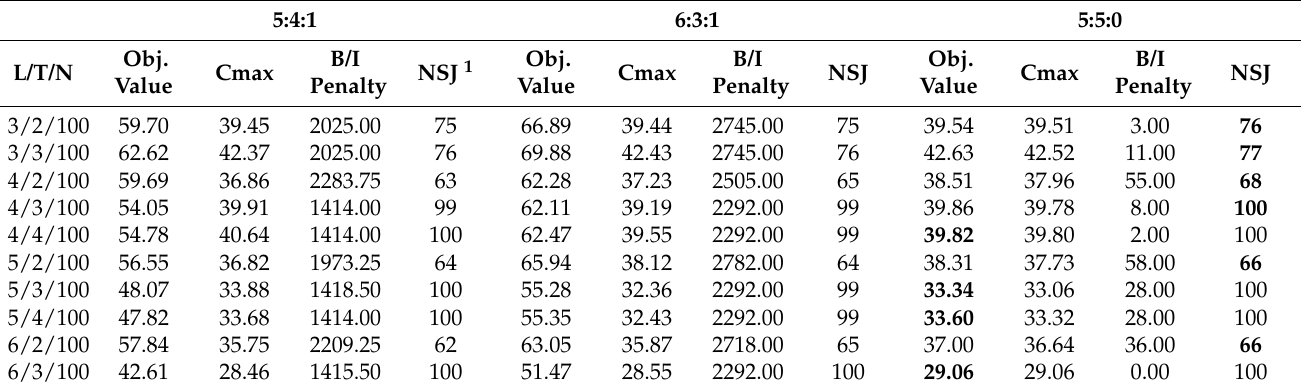
Table 4. The impacts of various B/I ratios.